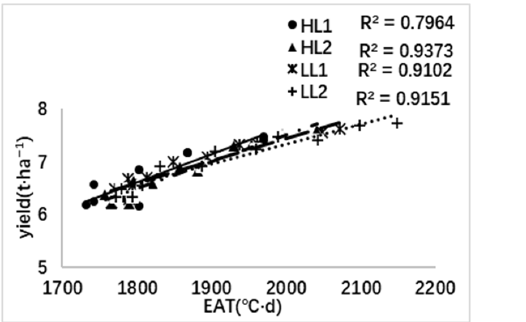
Figure 1. Correlation between temperature and yield during the whole growth period. HL1: 2017–